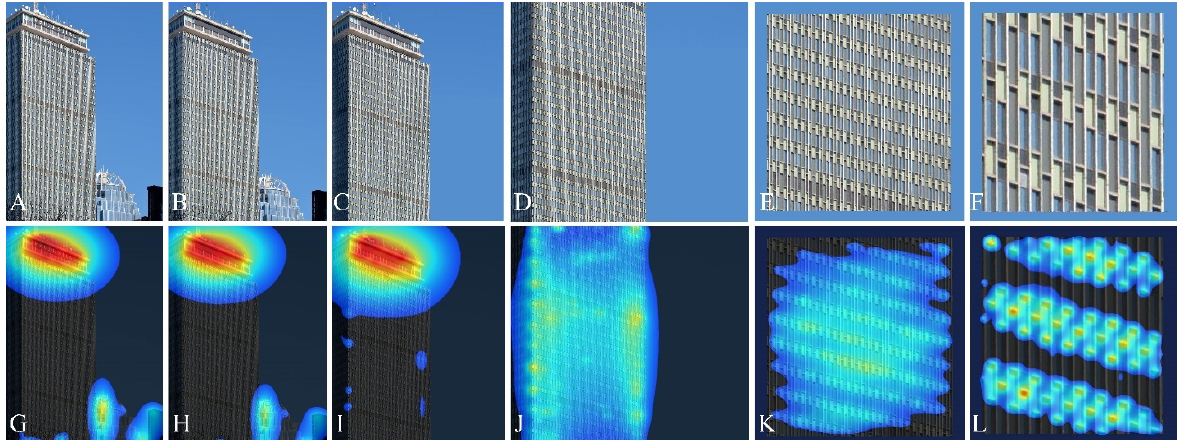
Figure 8. ( A ) The Prudential Tower in Boston, built in the International Style in the 1960s, with ( G ) its eye-tracking simulation heatmap. Simplified views with their heatmaps ( B , H ), ( C , I ) and zoomed in views ( C , I ), ( D , J ), ( E , K ), ( F , L ) leading to fragmentation.